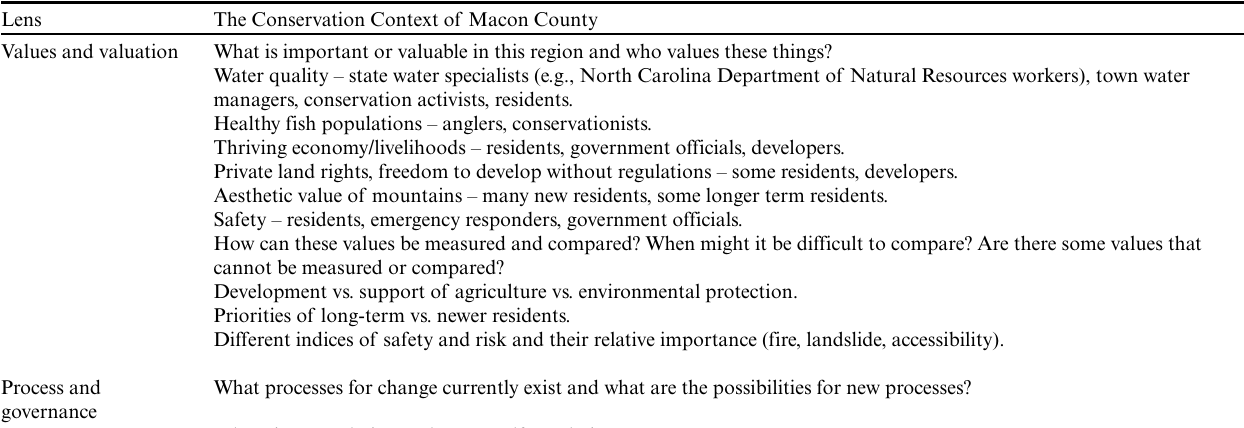
Table 1 . Integrative Framework (IF) as applied to Macon County, North Carolina, USA. This table illustrates a sampling of the questions that arise from use of the integrative framework and some brief examples of the information that these questions elicit. This table is not meant to be an exhaustive chronicling of the questions raised by the IF or of the data produced. Rather, it is meant to illustrate how looking through different lenses highlights and obscures different areas of the problem and how when the lenses are taken together we arrive at a more holistic understanding of the issue or